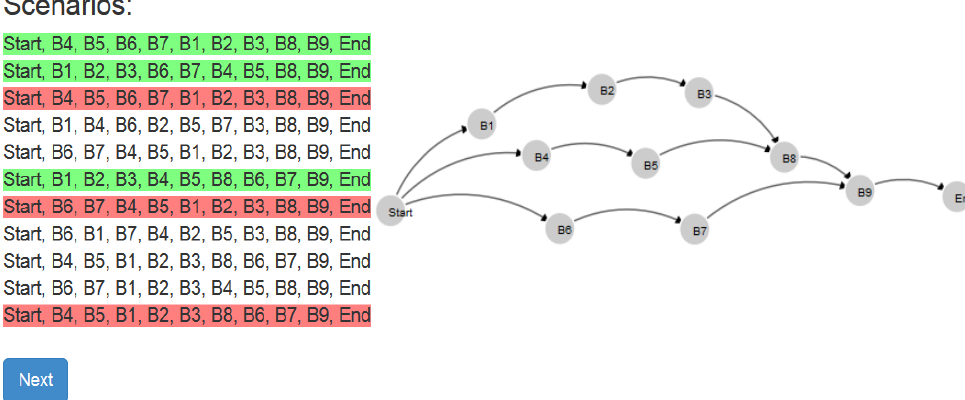
Figure 12. The final model of the observed process example.